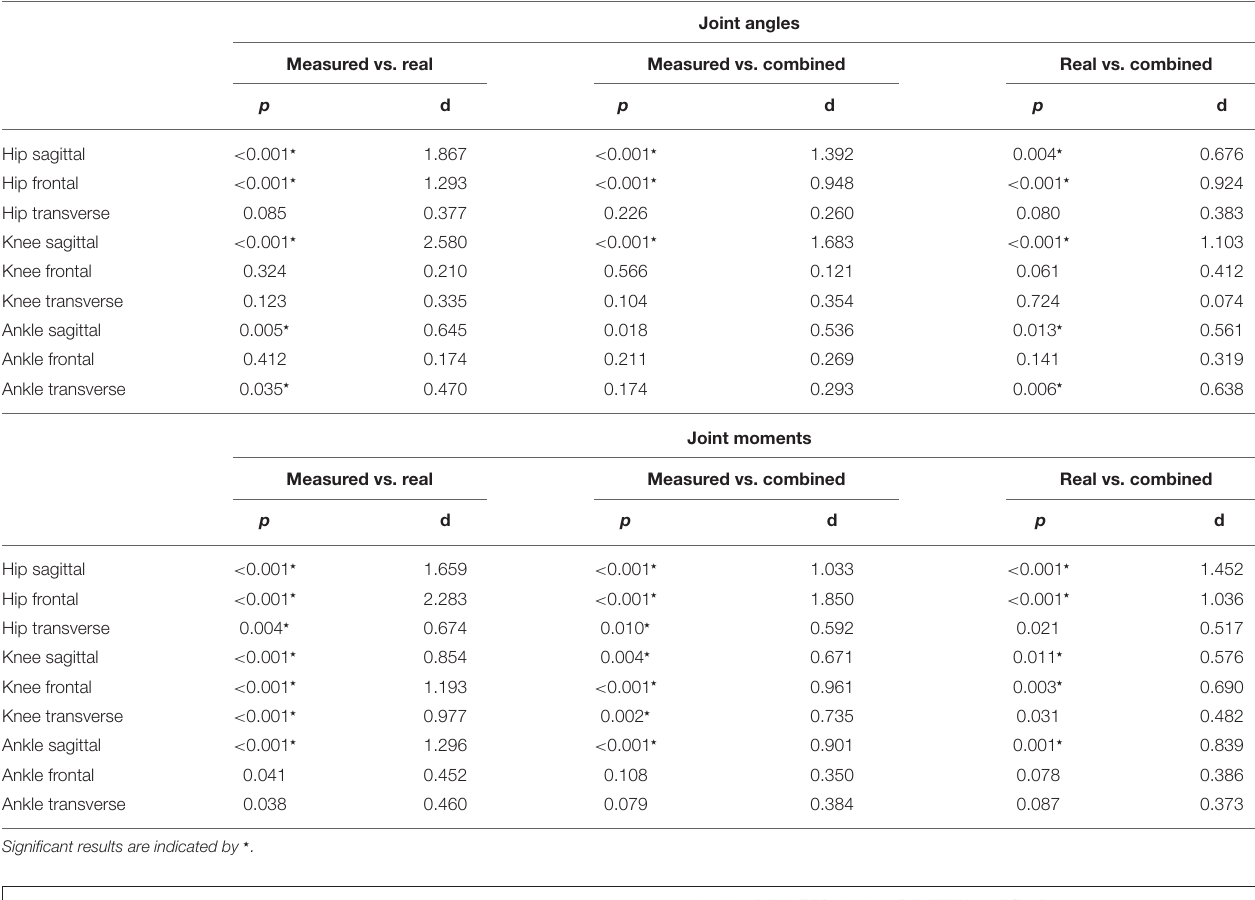
TABLE 1 | Results of the statistical analysis of the peak prediction.